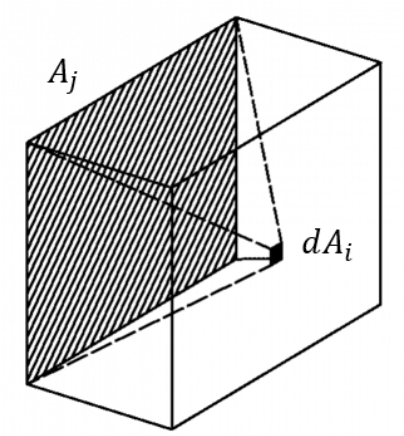
Figure 5. Calculation of the mean radiant temperature from IDA ICE [26].